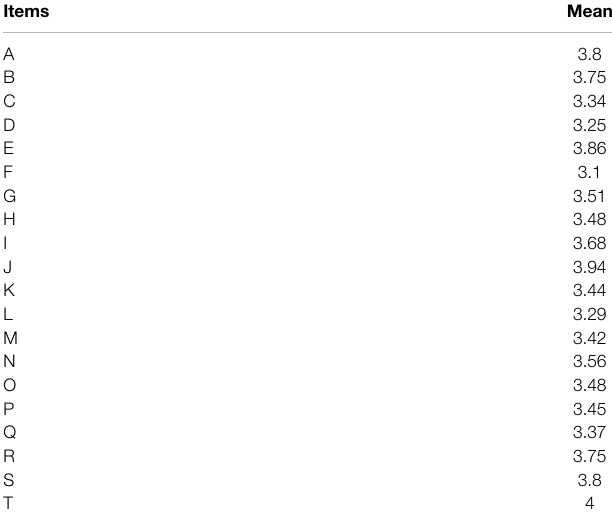
TABLE 3 | Teachers ’ response and feedback on the CPD programme. Items Mean